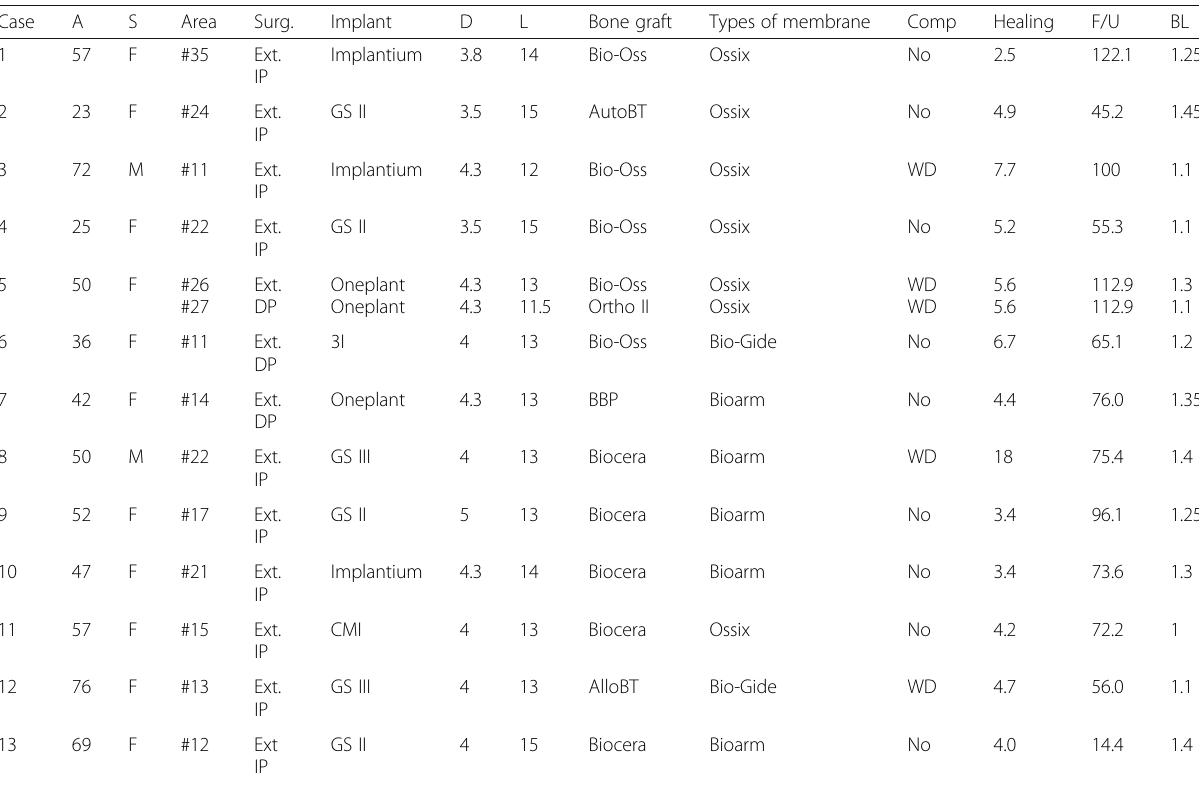
Table 2 Socket sealing using resorbable collagen